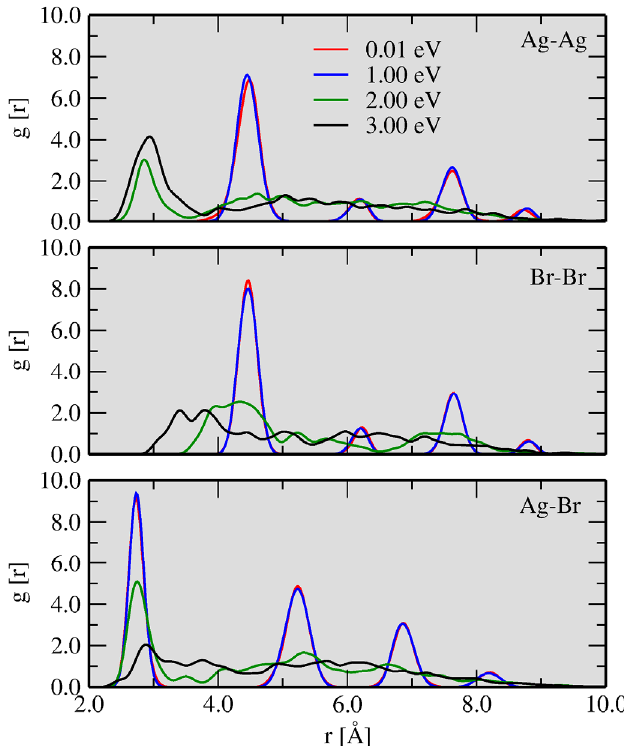
Figure 6. Radial distribution function for the geometries shown in Figure 4. In the top, center and bottom panels, the radial distribution function is calculated for Ag-Ag, Br-Br and AgBr, respectively, as a function of the electronic temperature.